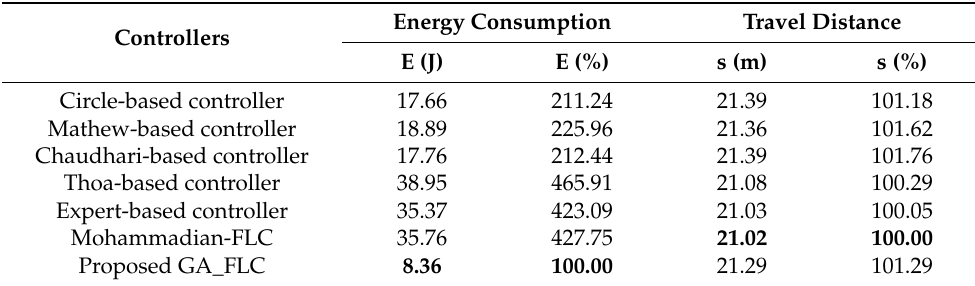
Table 14. Energy consumption and travel distance of the robot when the robot tracks the straightfor- ward path by the different controllers. Bold values are the best in the appropriate column.